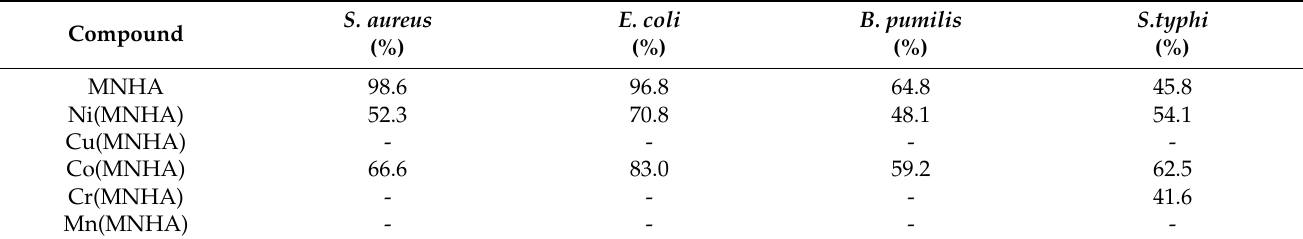
Table 6. Antibacterial assay of compounds 3 – 8 .